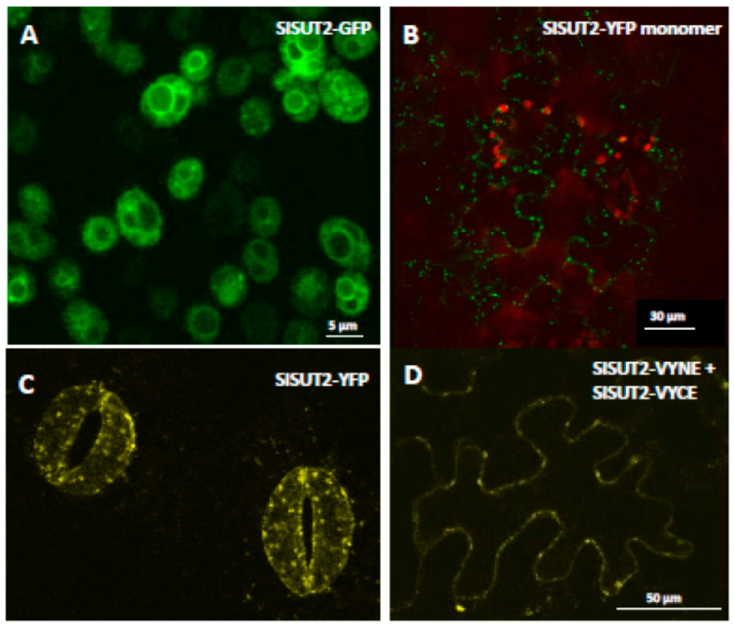
Figure 2. SlSUT2-GFP and SlSUT2-YFP fusion proteins heterologously expressed in yeast and in planta. ( A ). SlSUT2-GFP fusion construct expressed in Saccharomyces cerevisiae is not targeted to the plasma membrane. ( B ). SlSUT2 in pK7GW2.0 (YFP) transiently expressed in N. benthamiana leaves 4 d after infiltration. ( C ). Stable expression of SlSUT2-YFP under control of the CaMV35S promoter in Nicotiana tabacum . ( D ). BiFC experiments showing SlSUT2 homodimerization. Note that homodimers show increased plasma membrane targeting compared to the monomeric form of SlSUT2.